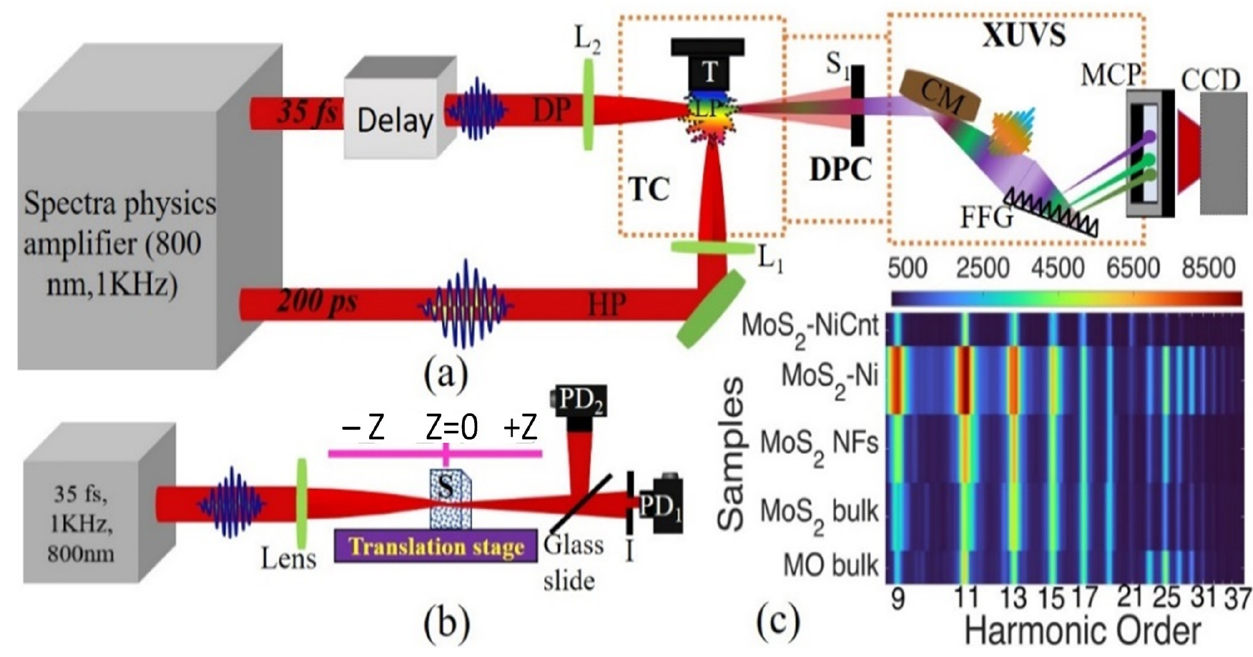
Figure 2. ( a ) Schematic for high-order harmonics generation in plasma. HP: heating pulses; DP: driving femtosecond pulses; L 1,2 : focusing lenses; T: target; TC: target chamber; LP: laser plasma; DPC: differential pump chamber; S 1 : slit; XUVS: extreme ultraviolet spectrometer; MCP: micro-channel plate; CCD: CCD camera; CM: cylindrical gold-coated mirror; FFG: flat-field grating; Delay: optical delay line. ( b ) Schematic for Z-Scan studies. PD 1,2 : Photodiodes, S: Samples, I: iris. ( c ) 2d color plots of harmonic spectra obtained from the molybdenum-contained materials using picosecond HP.